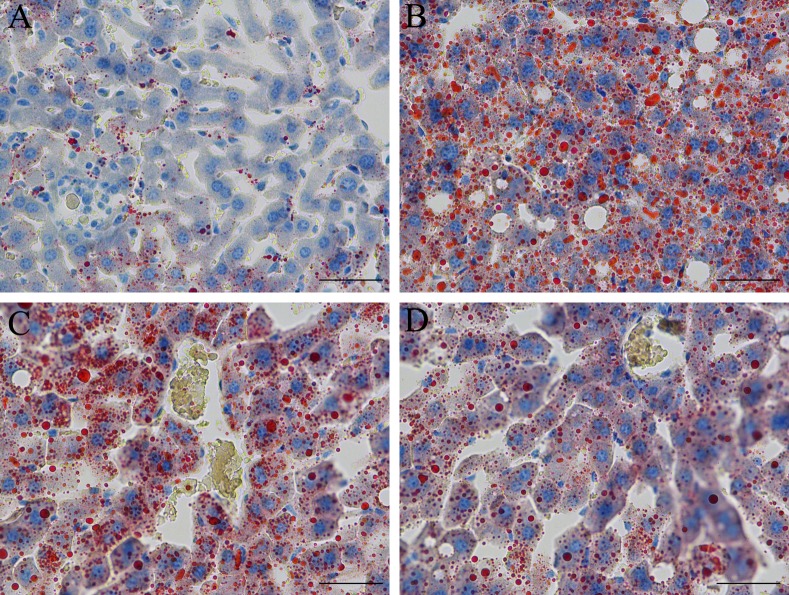
Oil Red O staining observation of rat liver tissue (original magnification: ×400, scale bars = 50 μm).(A) STD group. (B) HFD group. (C) HFD-RES group. (D) HFD-CR group.